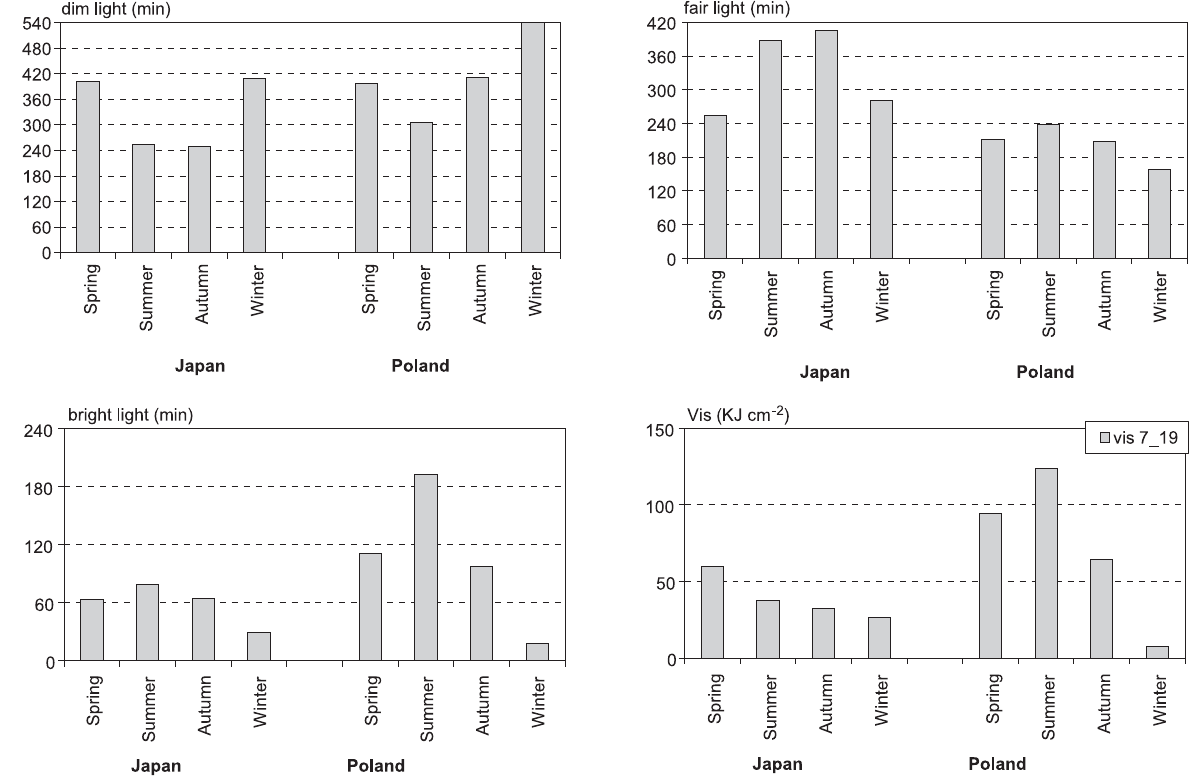
Fig. 4. Seasonal and regional differences in individual lightning characteristics the subject were exposed for: time of expo- sure to dim, fair and bright light and daytime totals of